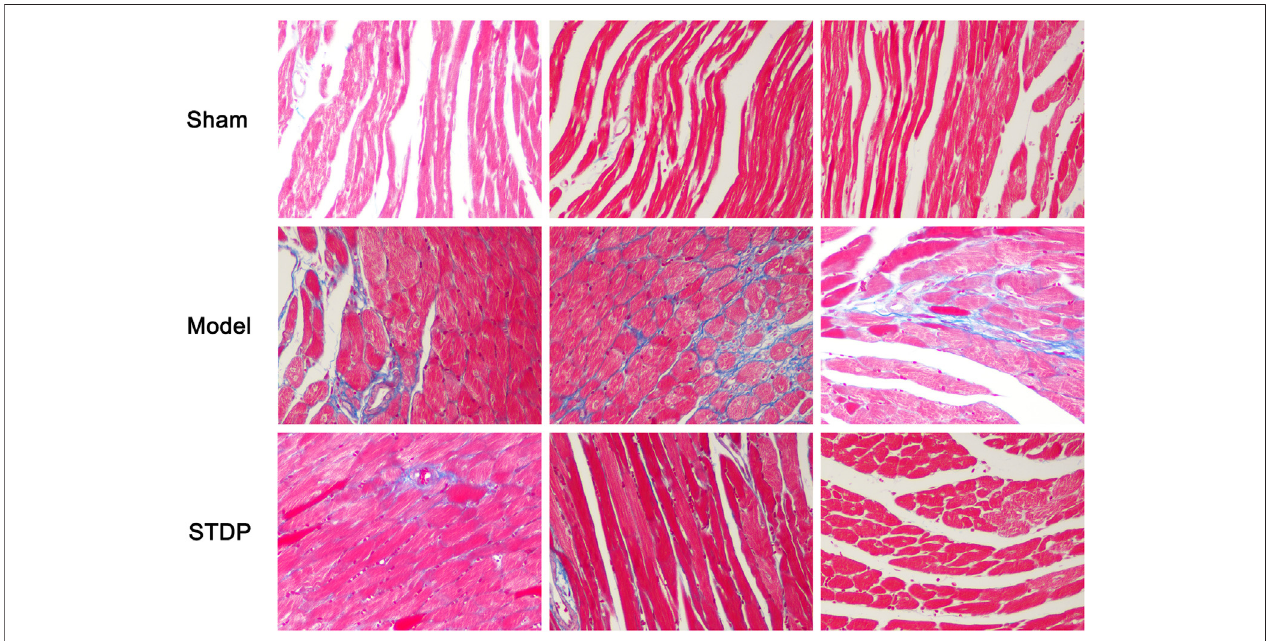
FIGURE 3 | STDP attenuates myocardial fi brosis in CHF mice. After 6 weeks of STDP treatment, representative images of mouse left ventricular sections stained with Masson ’ s trichrome and photographed with fl uorescence microscope (magni fi cation, × 400). Bars (cid:1) 50 µm. n (cid:1) 3. Collagen fi bers were stained blue and myocytes were stained red, re fl ecting the degree of myocardial fi